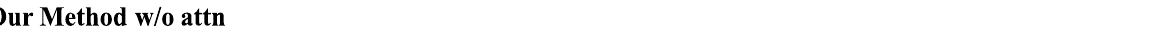
model. The fourth is the summary generated by our model without the auxiliary task. The fifth is the summary generated by our model without the attention constraint. The last is the summary generated by the vanilla sequence-to-sequence attentional